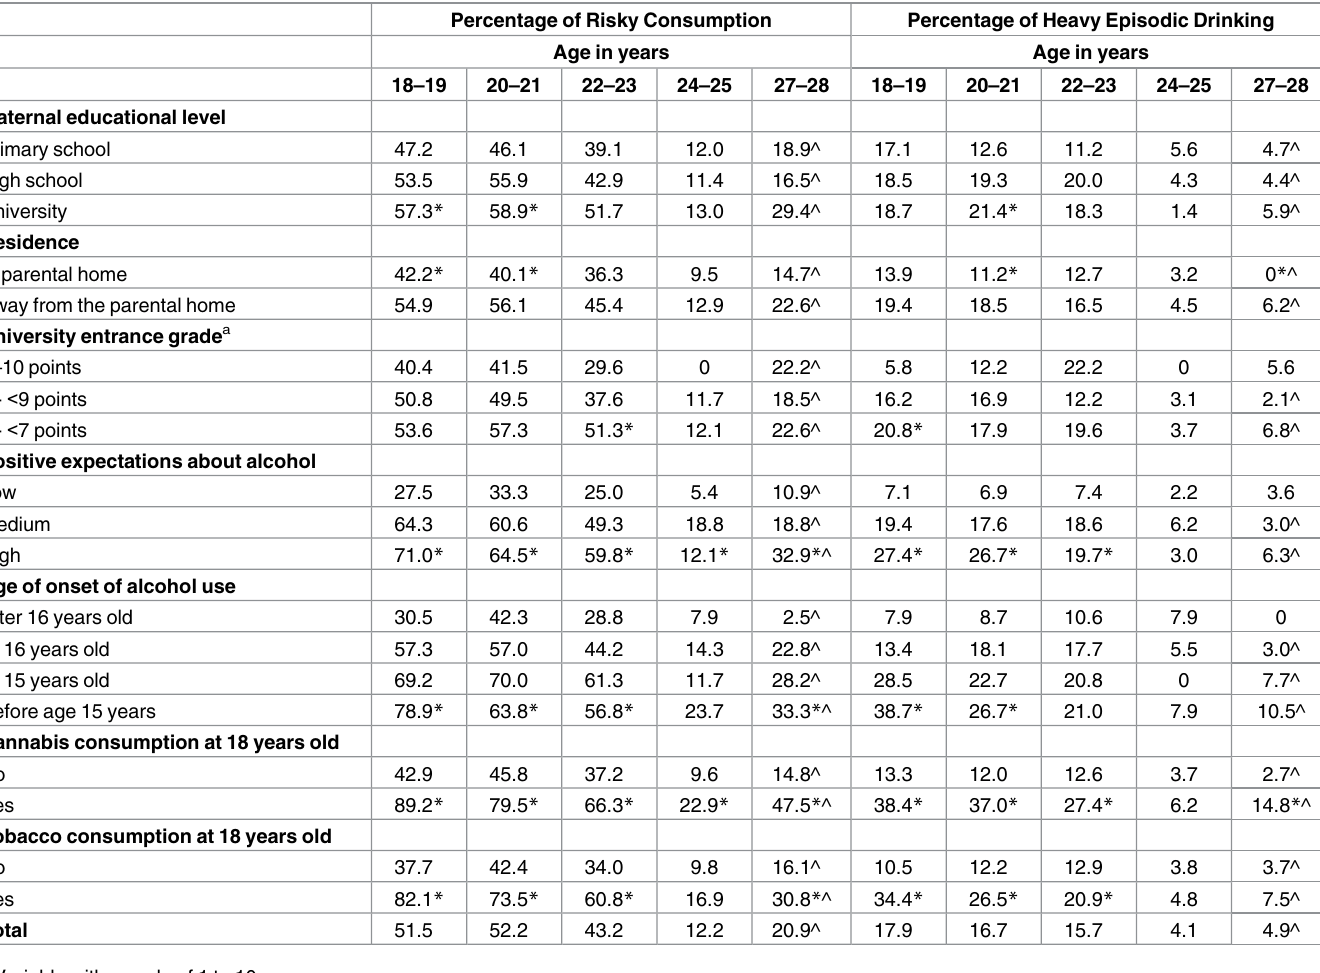
Table 3. Main characteristics of the female subjects and alcohol consumption at age 18, 20, 22, 24 and 27